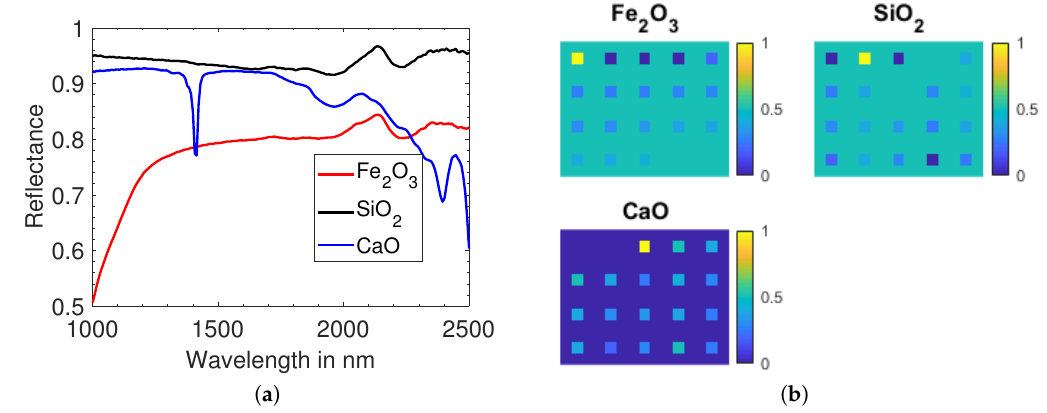
Figure 1. Simulated image. ( a ): Endmembers; ( b ): abundance maps.